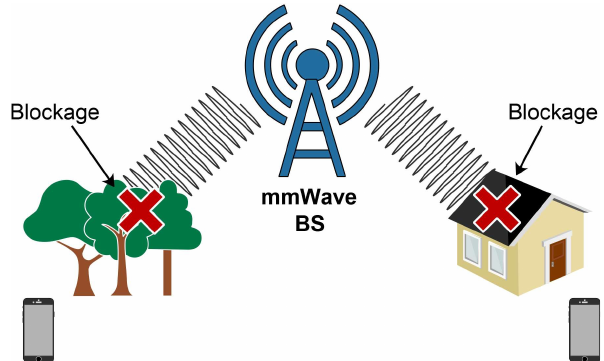
Figure 8. High-frequency millimetre waves experiencing blockages.